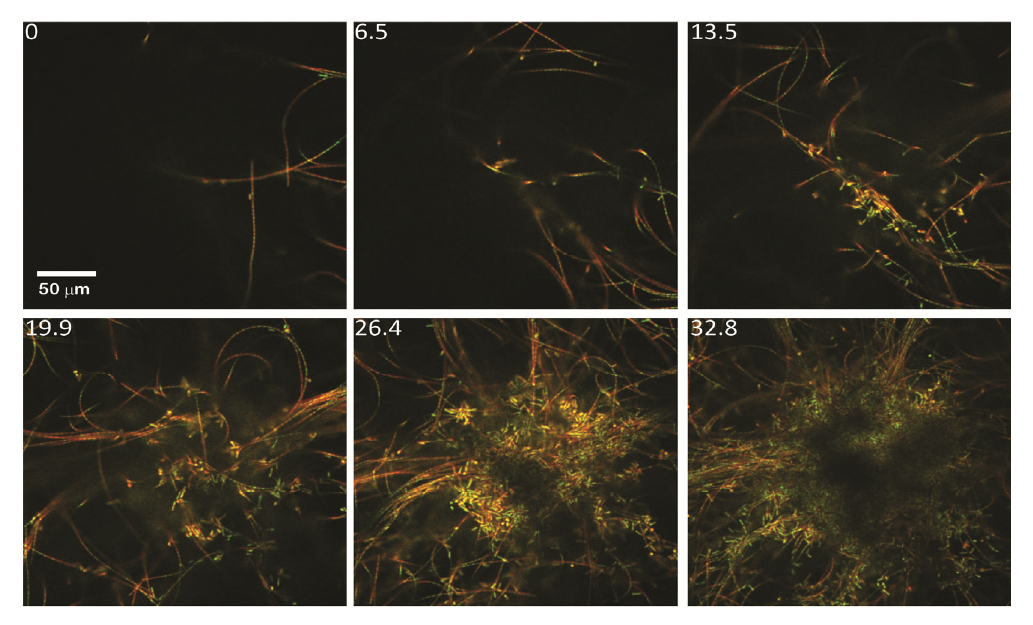
Figure 3. Top-down views of cyanobacteria and other microbes in a clump. Numbers in each epifluorescence confocal micrograph denote depths in μ m, with 0 μ m denoting the top and 32.8 μ m denoting the bottom. Red areas show Chl a autofluorescence. Green fluorescence tracks the presence of DNA stained by Sytox ® Green (Invitrogen, Carlsbad, CA,